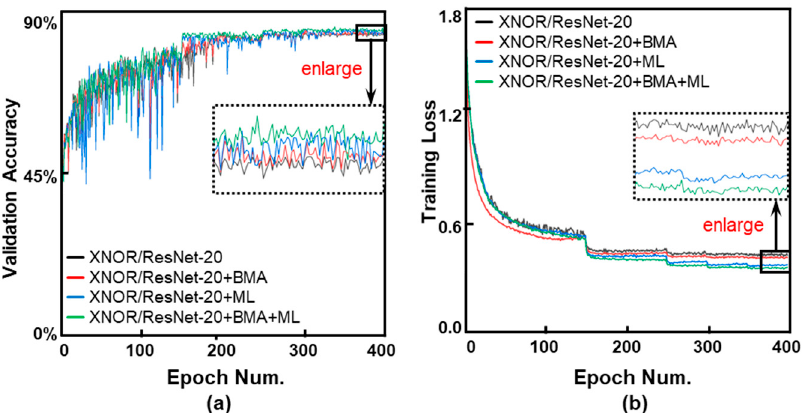
Figure 5. ( a ) Validation accuracy curves and ( b ) Training loss curves during the training process. Baselined XNOR-Net/ResNet-20, improved three schemes with BMA, ML, and both BMA+ML are evaluated and illustrated. All cases are with λ = 10 − 4 . Table 3. Accuracy results of XNOR/ResNet-20 baseline and improved versions with our proposed ML, BMA, and both ML+BMA (all three cases are with λ = 10 − 4 ). The best results are marked in bold.